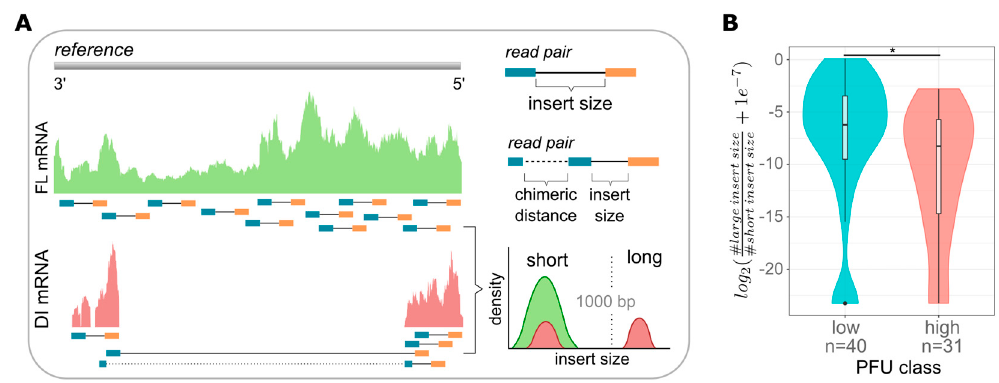
Figure 4. Computational workflow for the analysis of DI mRNAs and dependency of DI mRNAs on single-cell virus yield. At 12 hpi, single PR8-infected MDCK cells (MOI = 10) were investigated for released virus yields by the plaque assay (as shown in Figure 1) and the presence of DI mRNAs on S1–S3 by scRNA-seq. ( A ) Next-generation sequencing (NGS)-based computational workflow to detect DI mRNAs. Read pairs were mapped to the influenza reference genome. The estimated insert sizes were gathered from the alignment files. Typically, in the absence of structural variation, read pairs have an expected average insert size of about 250 nucleotides, which refers to FL mRNA. However, in the presence of large internal deletions, the insert size is larger than 1000 nucleotides, which refers to DI mRNAs. Chimeric reads spanning the deleted region can be used to locate the position of the deletion with its actual length. ( B ) Ratio of DI to FL mRNAs in cells classified as “low”- and “high”-yield single cells (as shown in Figure 3B). The log 2 -ratio between the number of large insert sizes and short insert sizes was used and a pseudo-count of 1e-7 was added to avoid a log of zero. Colors indicate the lower and upper 22.86% of cells with respect to the virus yield (“low” and “high”, respectively). *, p < 0.01 by the Wilcoxon rank sum test. The pooled data of multiple independent experiments are depicted ( n = 3).